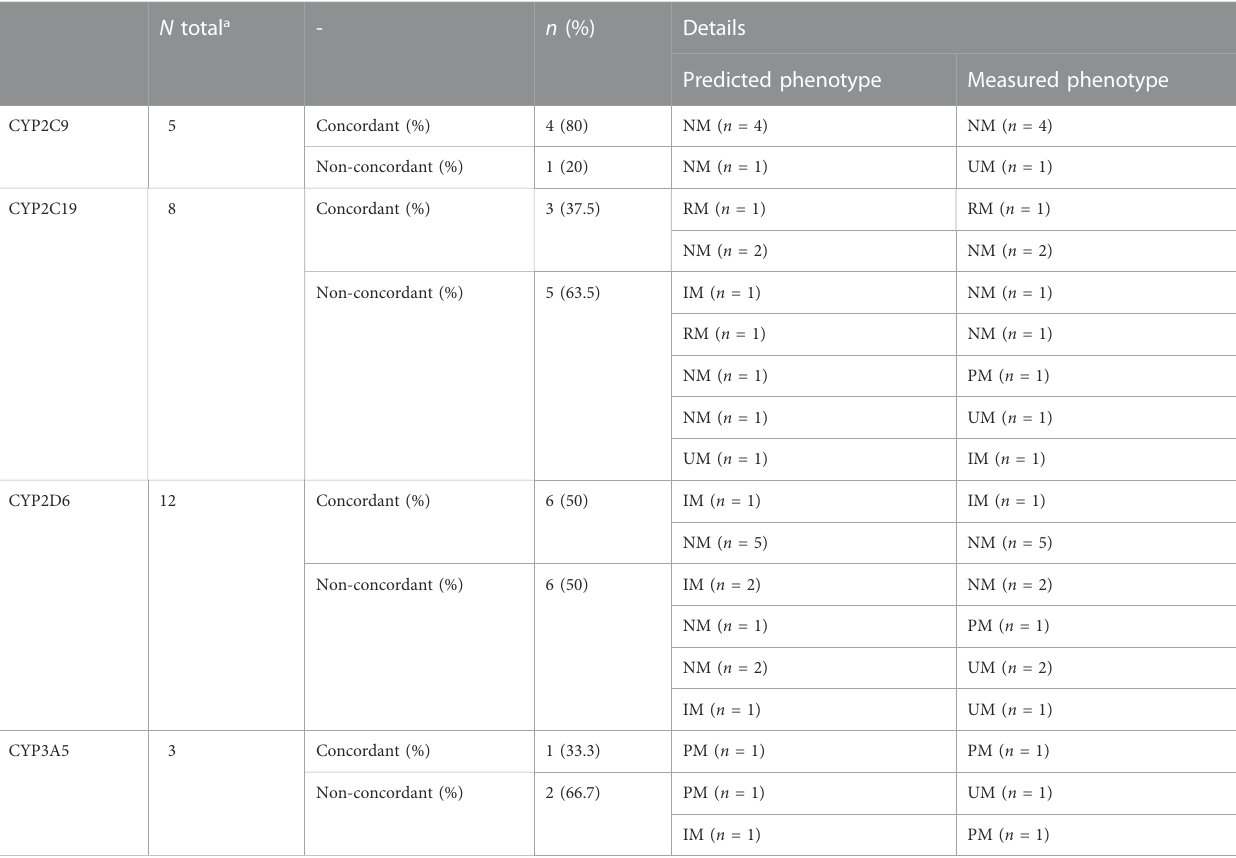
TABLE 2 Concordance between the predicted and measured